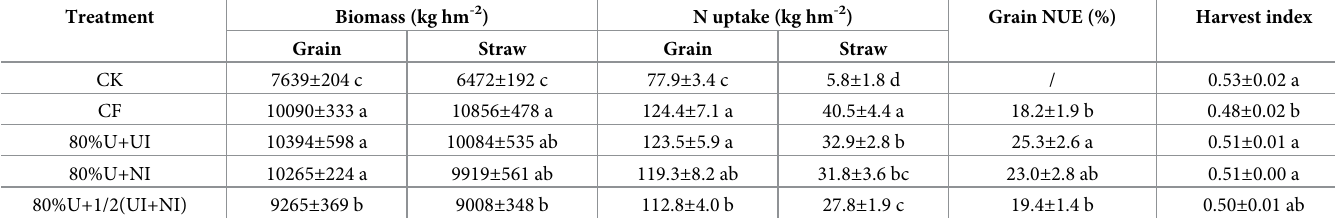
Values are means+SD (n = 3). Values in the same column followed by different lowercase letters are significantly different ( p < 0.05). CK, no N fertilizer input; CF, conventional fertilization; 80%U+UI, 80%U+NI and 80%U+1/2(UI+NI) indicate 80% of urea input with NBPT, with DMPP and with half NBPT and half DMPP,